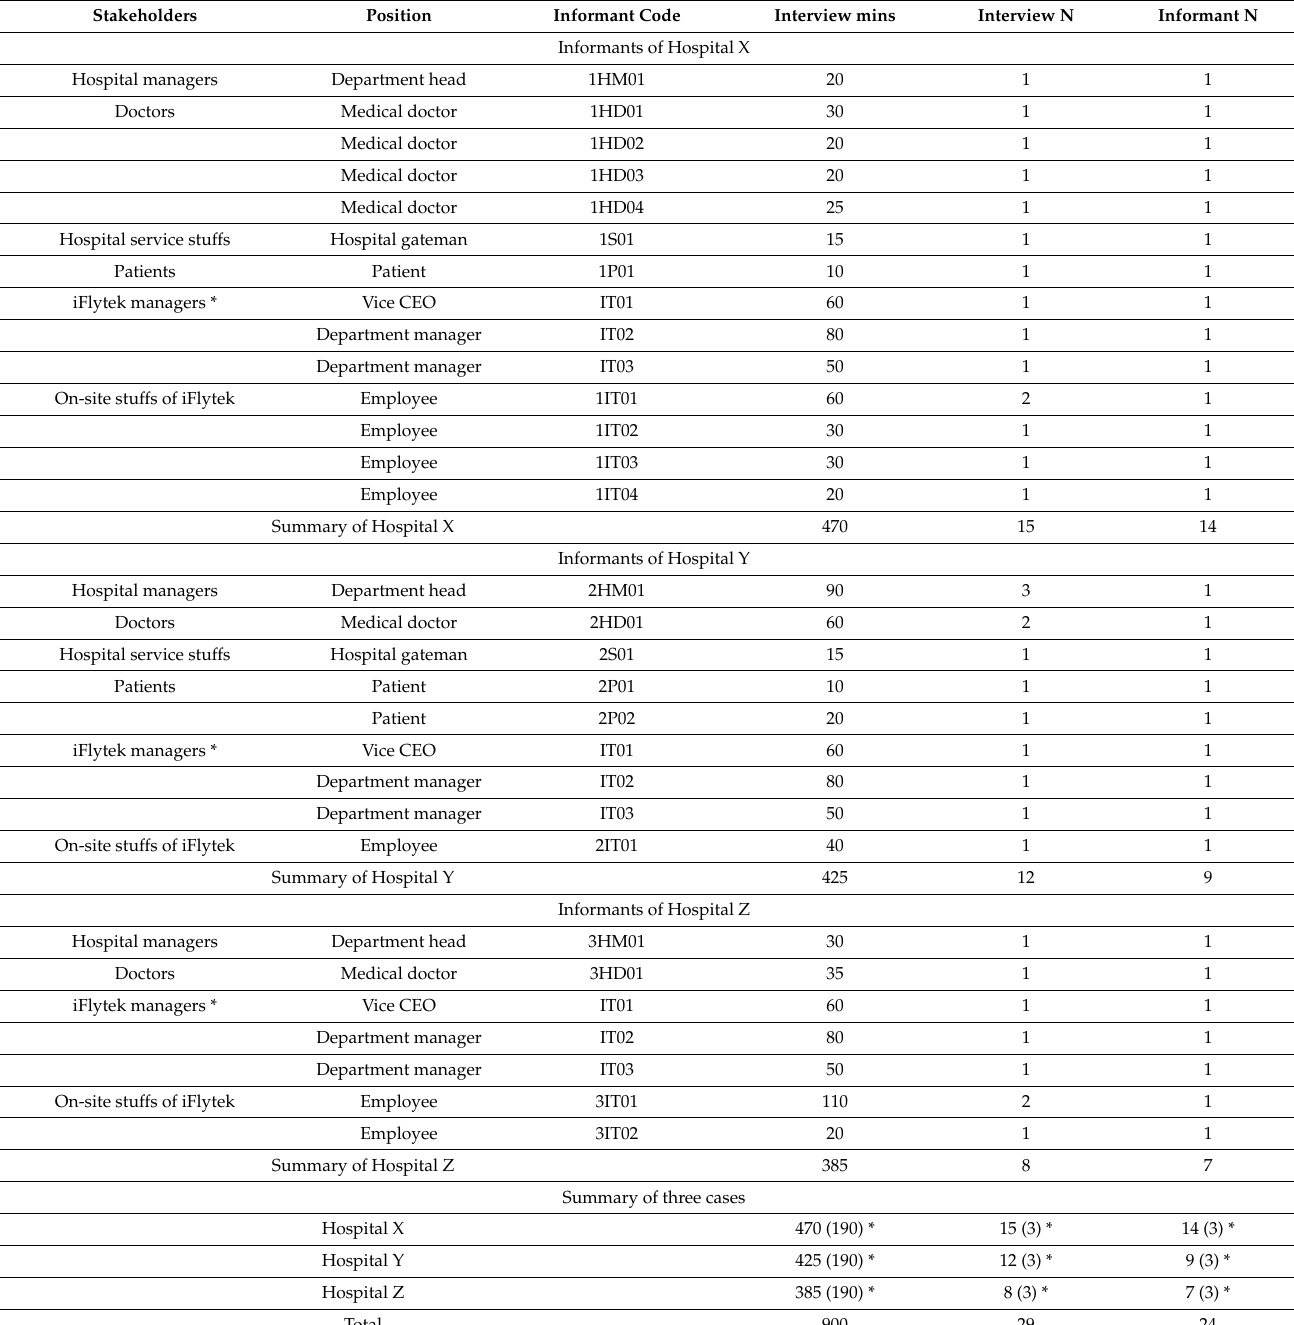
Table 3. Overview of case interview